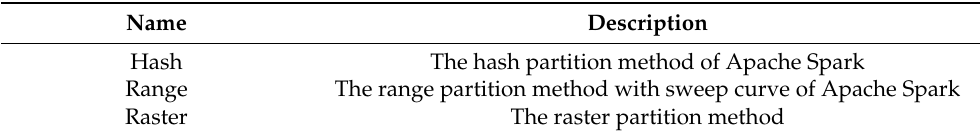
Table 1. Methods and nomenclature used in the comparative experiments.